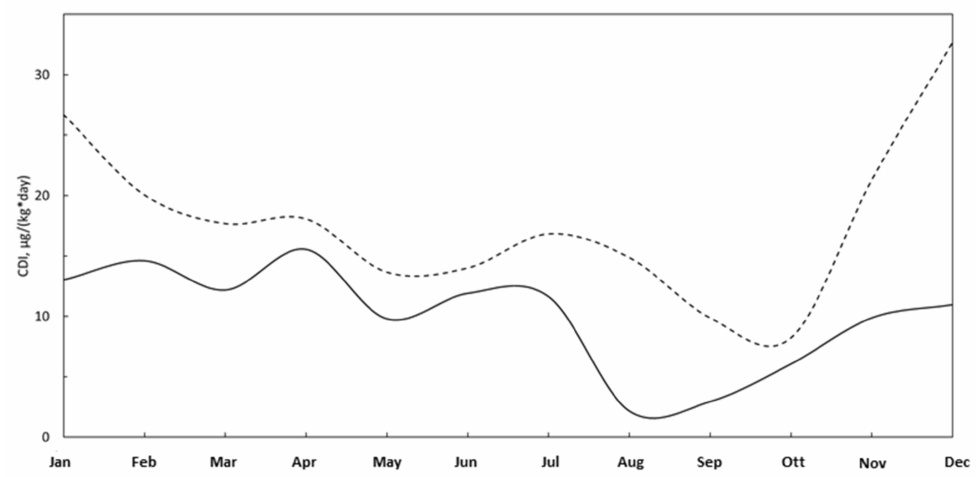
Figure 12. Nickel (Ni) CDI for the HI (solid black line) and LI (dashed black line) area for every month in 2016.